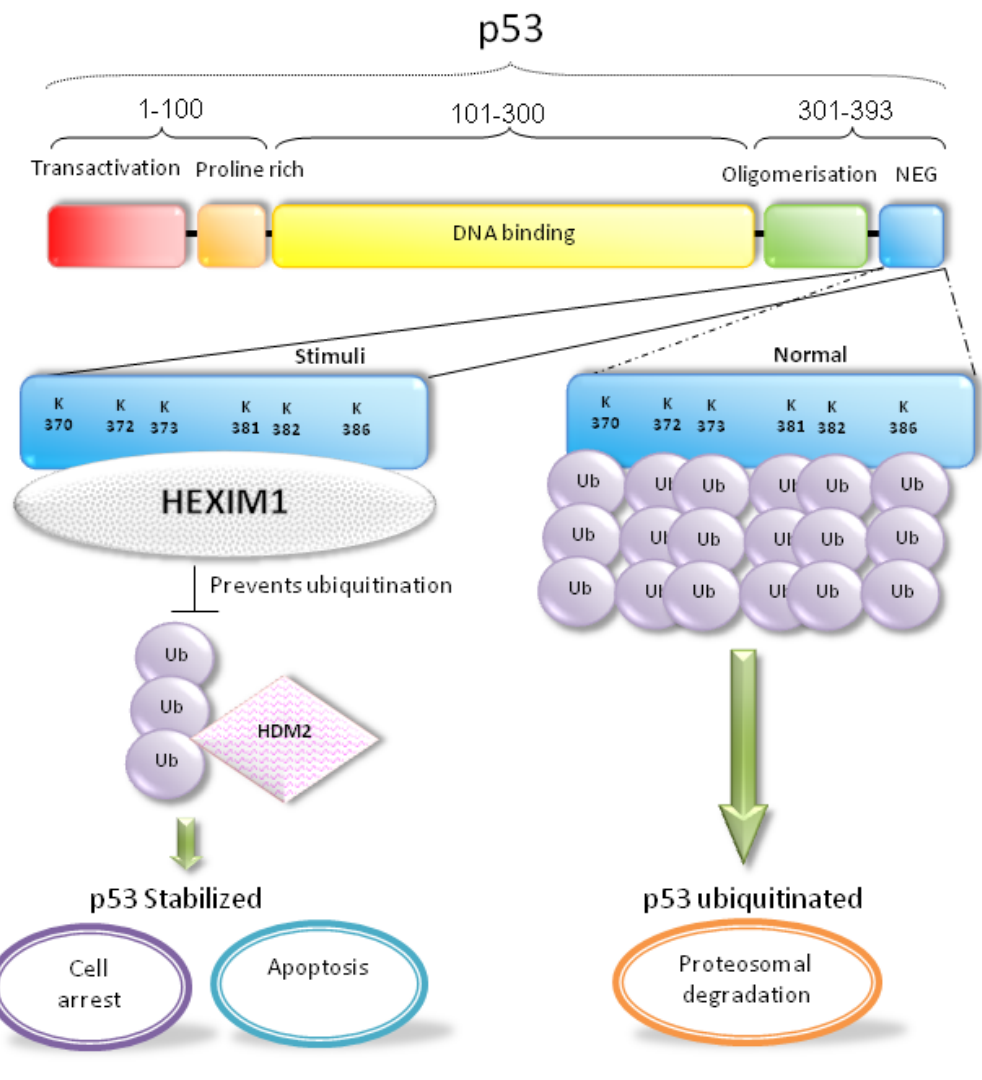
Figure 4. The NEG domain of p53 contains the lysine residues targeted by HDM2 for ubiquitination and degradation of p53. Domain study of p53 reveals that the NEG domain is essential for the association between HEXIM1 and p53 [113]. It is proposed